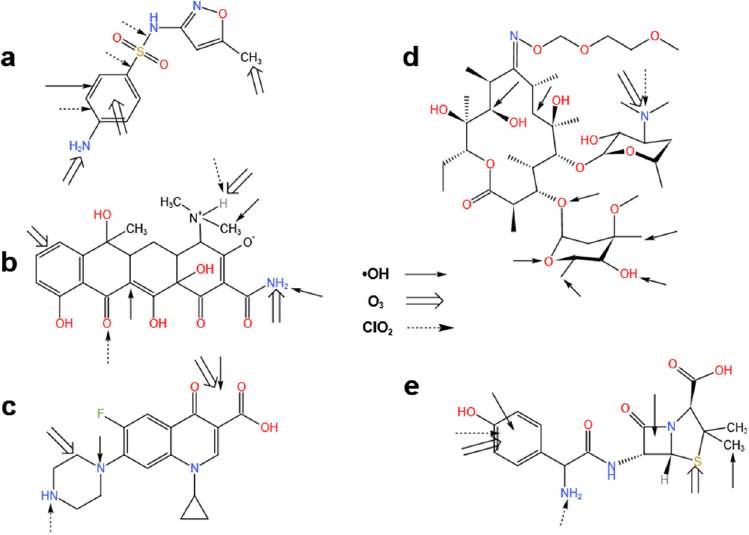
Figure 7. The attack sites of O 3 , ·OH, and ClO 2 against five antibiotics (( a ) sulfamethoxazole, ( b ) tetracycline, ( c ) ciprofloxacin, ( d ) roxithromycin, ( e ) amoxicillin) according to [124–134]. Ostman et al. found removal rates of over 90% for ciprofloxacin, erythromycin,